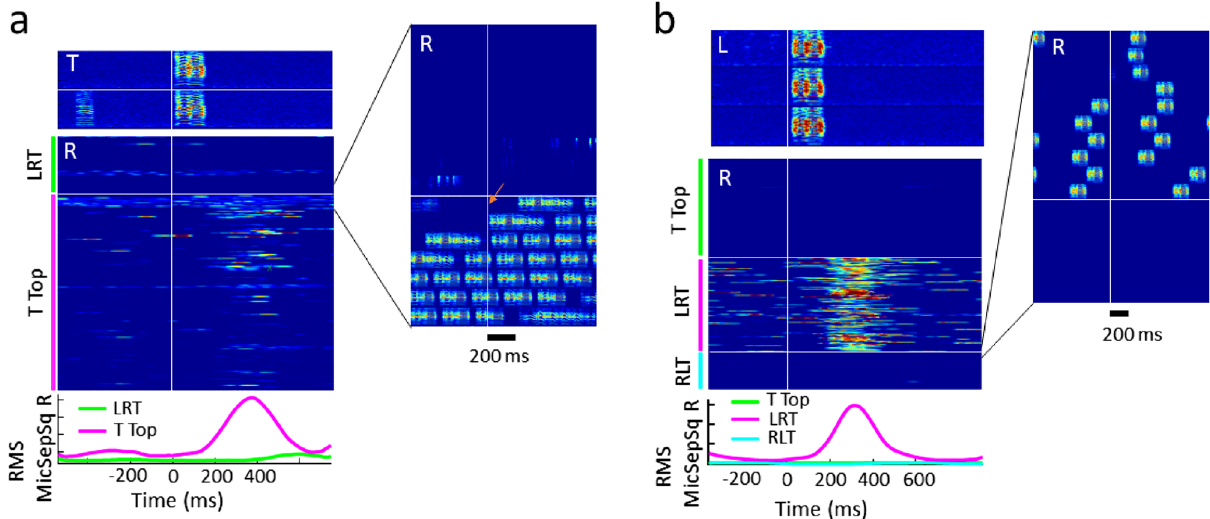
Figure 6. The communication network constrains vocal interactions. Vocal interactions can change very sensitively in response to switches between communication networks, shown here for hierarchical and cyclic networks. ( a ) Switch from L=>R=>T=>L (cyclic, LRT) to L<==>T<==>R (hierarchical, T top) leads to an initial string of call response in R to the first audible call in T (orange arrow in inset). Shown are spectrograms of two example calls in T (top) and several hundred responses in R depicted as a root-mean-square (RMS) stack plot (middle), aligned to the onset of the calls in T when T’s calls are not audible (LRT, top) and when they are (T top, bottom). The calling times in T run from top to bottom. The bottom curves represent the RMS MicSepSq R curves averaged over all calls in T in both conditions. R responds with a latency in the range 300–500 ms, with waning reliability. The inset on the right depicts spectrograms of responses in R right before the network switch (top) and right after the switch (bottom), aligned to the onsets of T’s calls (vertical white line). Both T and R produce dense strings of calls, which leads to multiple depictions of a given call in R in subsequent rows. ( b ) Switch from L<==>T<==>R (hierarchical, T top) to L=>R=>T=>L (cyclic, LRT) uncovers vigorous responses in R to calls in L (example spectrograms on top). However, L does not respond to R when the cyclic network changes direction to R=>L=>T=>R (cyclic, RLT). The inset on the right illustrates the immediate silence following the switch to the second cyclic